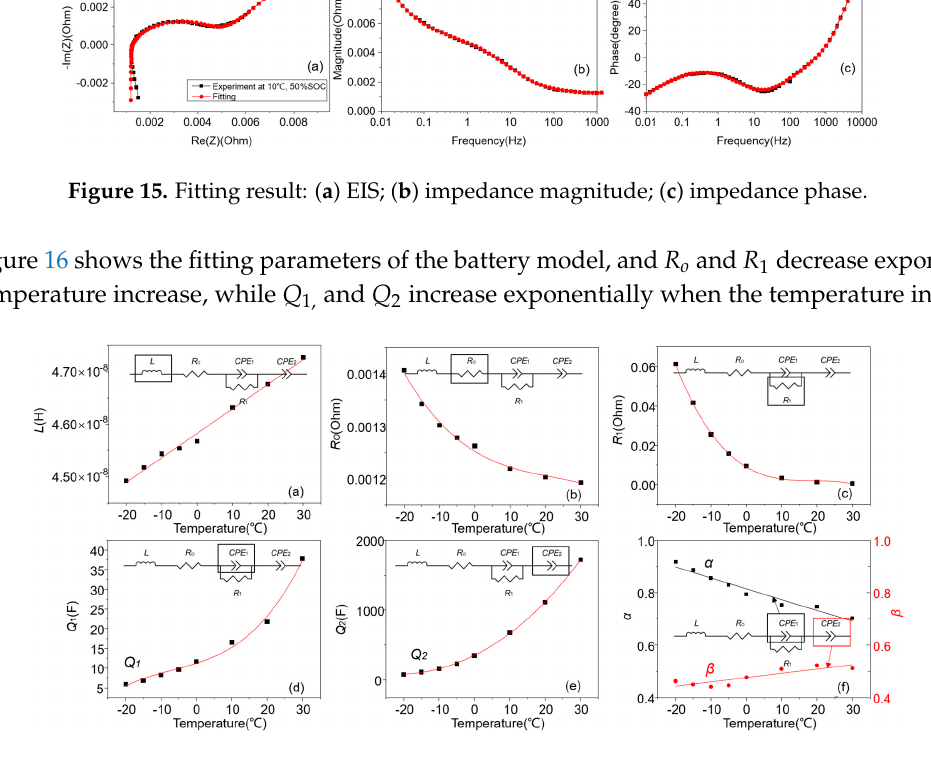
Figure 16. Parameters of battery non-linear impedance model: ( a ) inductance L ; ( b ) resistance R o ; ( c ) resistance R 1 ; ( d ) fractional coefficient of CPE 1 , Q 1 ; ( e ) fractional coefficient of CPE 2 , Q 2 ; ( f ) fractional order of CPE 1 and CPE 2 , α and β .